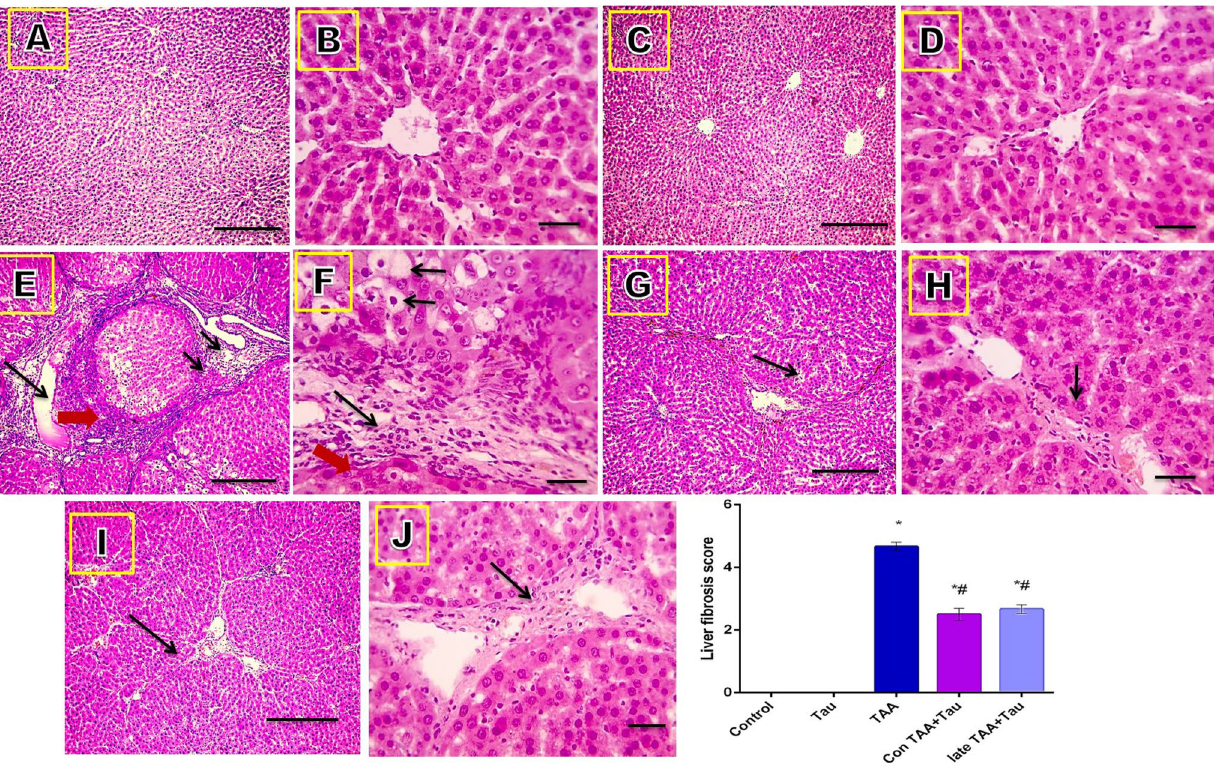
Figure 4. Microscopic pictures of H&E stained liver sections. ( A ) control group. ( B ) Tau group. ( C ) TAA group. ( D) : Con TAA + Tau group. ( E ) late TAA + Tau group. ( F ) liver fibrosis score. ( A,C,E,G,I ) X: 100 bar 100. ( B,D,F,H,J ) X: 400 bar 50. *: Significance against control group ( P < 0.05), #: Significance against TAA group ( P <